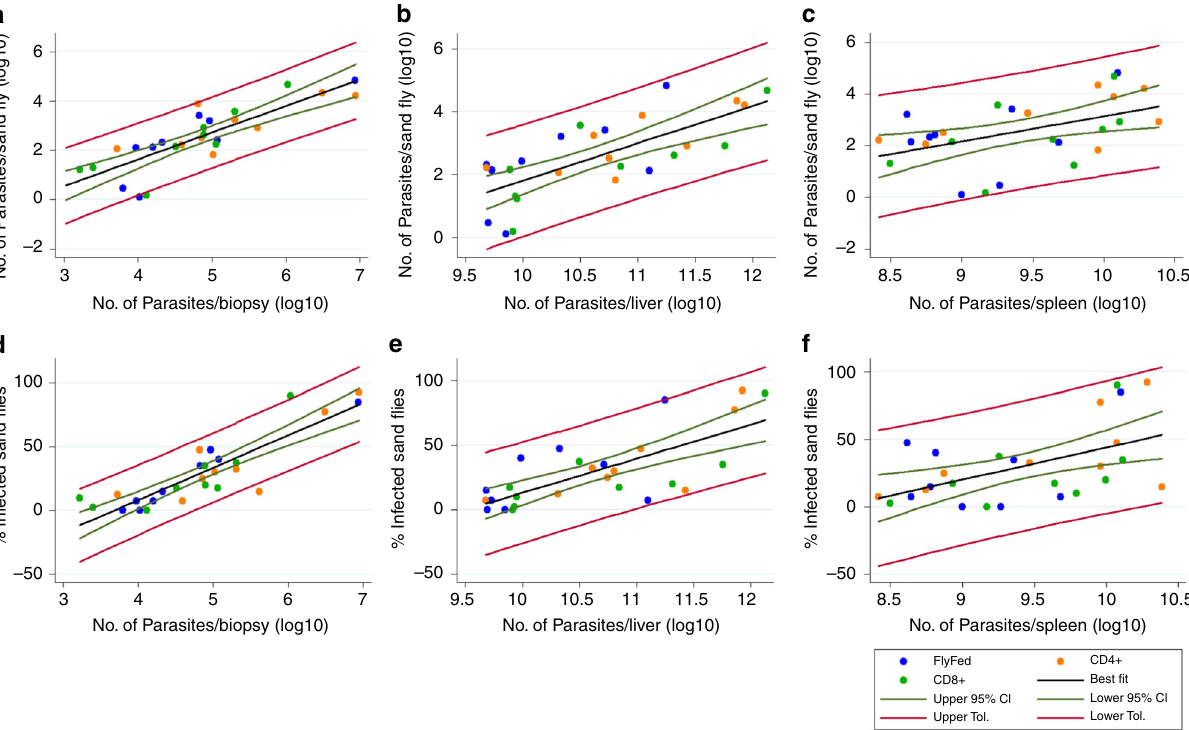
Fig. 3 Correlating tissue parasite load to outward transmission success. Correlation plots comparing sand fl y parasite load (determined by qPCR) with host parasite loads in a skin, b liver and c spleen (all determined by qPCR). Correlation plots comparing frequency of infected sand fl ies with host parasite loads d skin, e liver and f spleen (all determined by qPCR). Mice from all experimental groups were included in the analyses, but represented by group in the plots (see legend). The graphs show the line of best fi t ( black ), the 95% con fi dence intervals (CI; green ) and the tolerance bands ( red ). All qPCR data were log 10 -transformed prior to analysis. Biological replicates N = 9 per group, total N = patchy for mice of all groups (Supplementary Figs. 6, 7, 11-14).